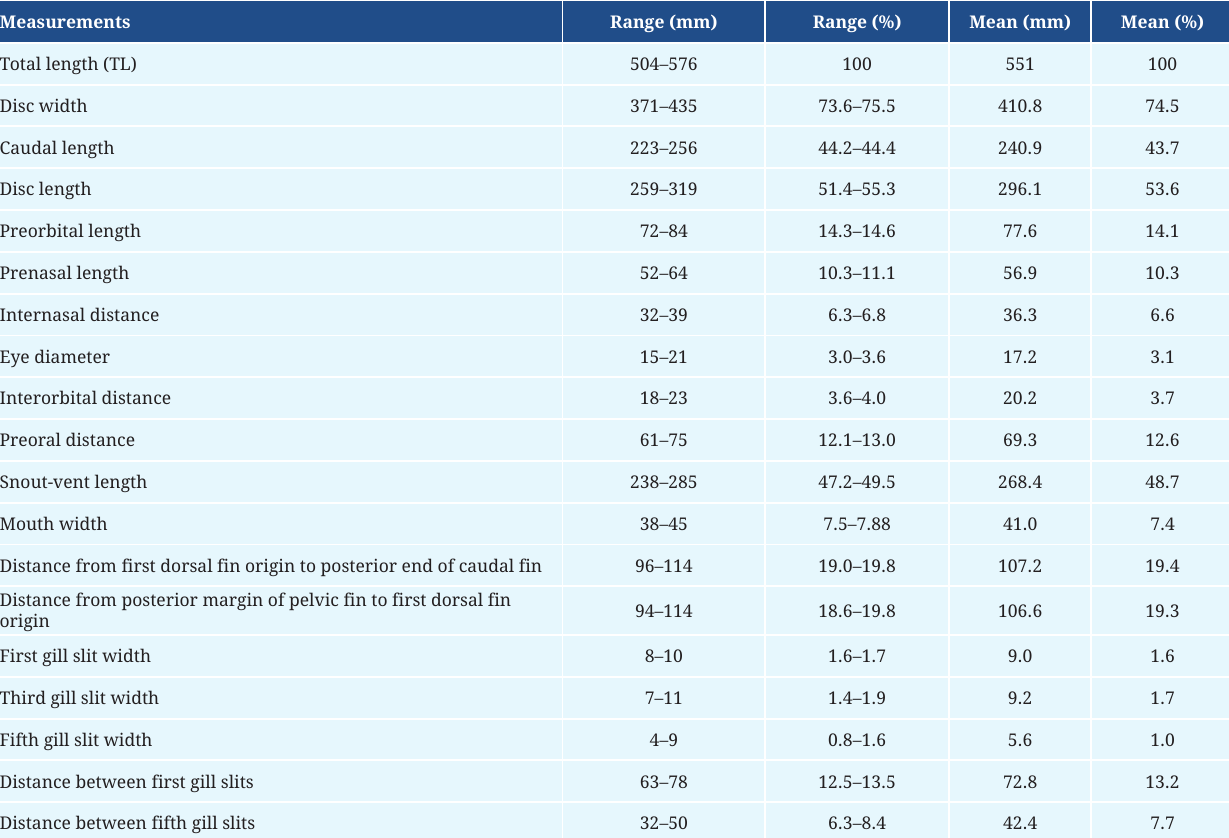
TABLE 4 | Morphometric measurements of nine specimens of Atlantoraja cyclophora in millimeters (mm) and proportions of total length